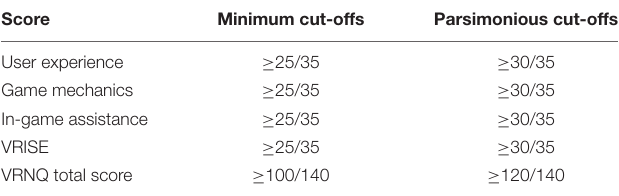
TABLE 4 | VRNQ cut-offs.